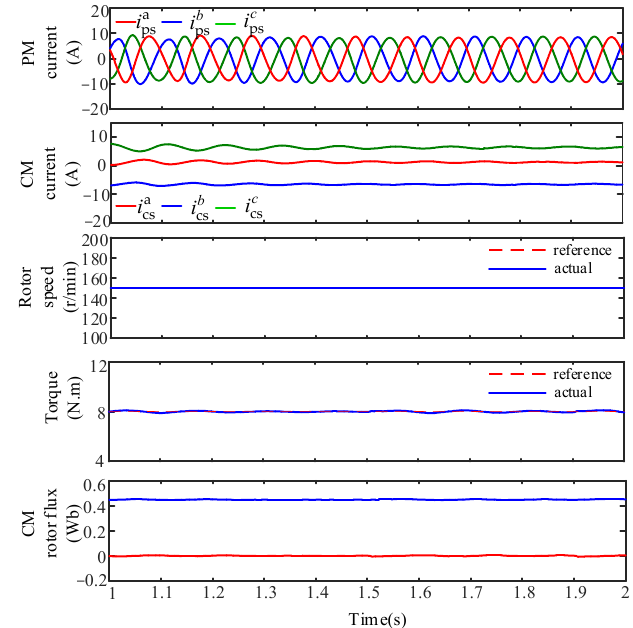
Figure 10. Simulation results at a synchronous speed of 150 r/min. As shown in Figure 10, the load torque is 8 N.m. The rotor speed is stable at a synchronous speed of 150 r/min (the CM power supply frequency is 0). The CM rotor flux and the rotor speed are controlled to track the reference value accurately.